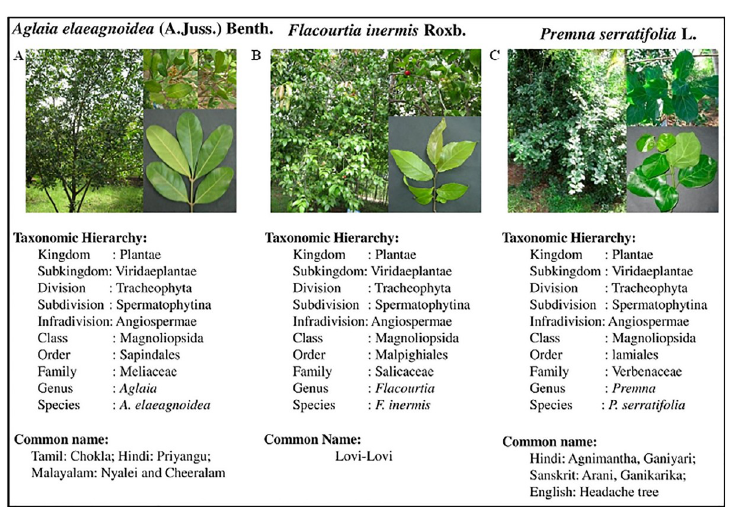
Fig 1. Taxonomical hierarchy of host plants: (a) A . elaeagnoidea , (b) F . inermis and (c) P . serratifolia .